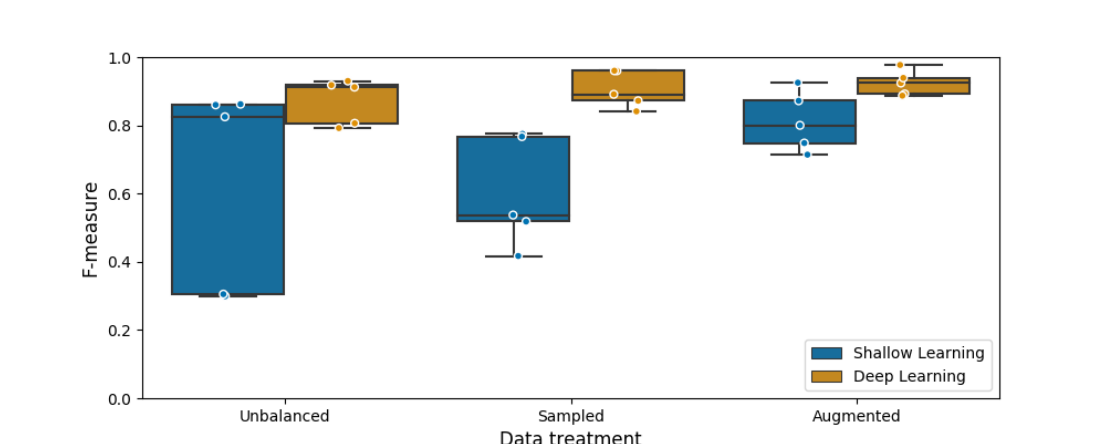
Figure 12. Comparison between conventional (shallow) and deep learning